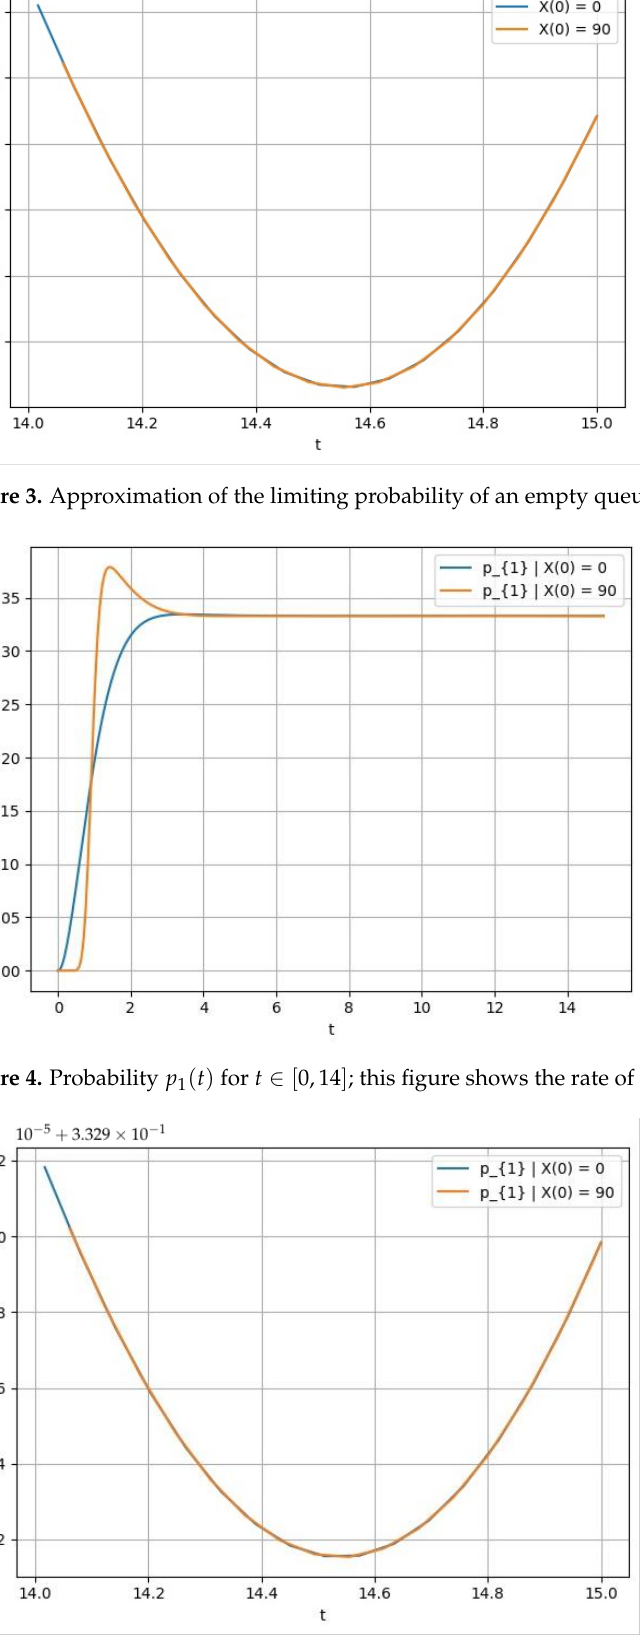
Figure 5. Approximation of the limiting probability p 1 ( t ) for t ∈ [ 14,15 ]